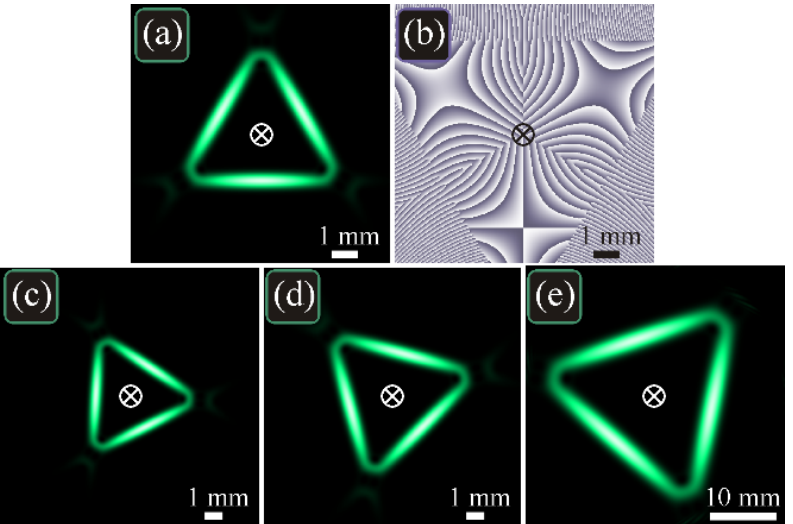
Figure 5. Intensity ( a , c – e ) and phase ( b ) distributions of the triangular propagation-invariant beam in the initial plane ( a , b ), in the near field z = z 0 /2 ( c ), at the Rayleigh distance z = z 0 ( d ), and in the far field z = 5 z 0 ( e ) for the following parameters: wavelength λ = 532 nm, waist radii of all three elliptic Gaussian beams σ x = 3102 µ m and σ y = 356 µ m ( w 0 = 500 µ m), coordinates of the beam centers ( x 0 p , y 0 p ) = ( r 0 cos ϕ p , r 0 sin ϕ p ) ( r 0 = 1.768 mm, ϕ p = π /6 + 2 π p /3, p = 0, 1, 2), tilt angles of the major axes of the ellipses to the x -axis α p = ϕ p + π /2, computation domain | x |, | y | ≤ R with R = 5 mm ( a , b ), R = 10 mm ( c , d ), and R = 20 mm ( e ). The cross in the center shows the optical axis, around which the diffraction pattern rotates on propagation. The initial field ( a , b ) was obtained by Equation (22) (with a phase shift 2 π /3 between the beams to avoid the destructive interference in the corners), whereas distributions in the other planes ( c – e ) were obtained by the numerical Fresnel